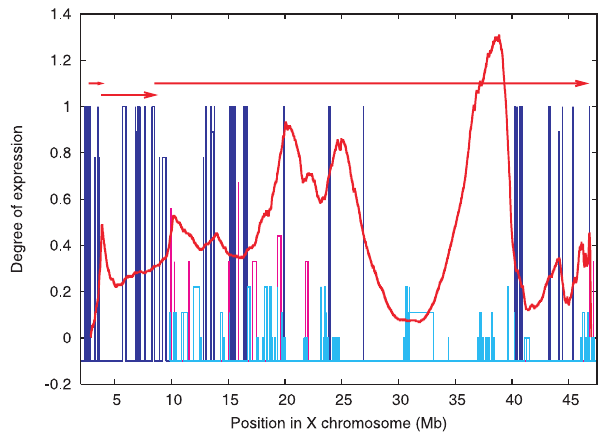
Figure 5. Ratio of synonymous (Ks) and non-synonymous (Ka) substitution rates of X-chromosome orthologs in the XAR. These rates were obtained from the pair of orthologs from G. gallus and human XAR, aligned by CLUSTALW2 [18], and analysed using the program DnaSP [19] (http://www.ub.es/dnasp/). The JS divergence (arbitrary scale) is superimposed on the